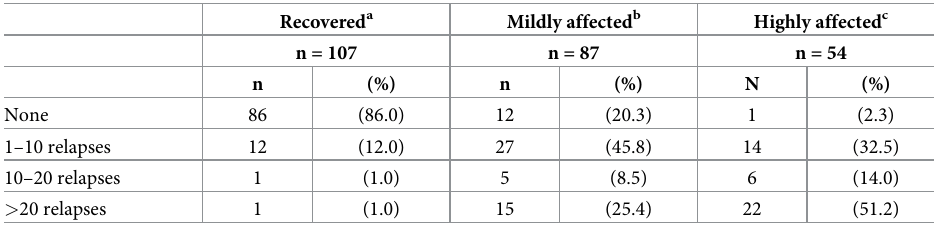
Table 3. Frequency of symptom relapses between 2015 and 2017. Recovered